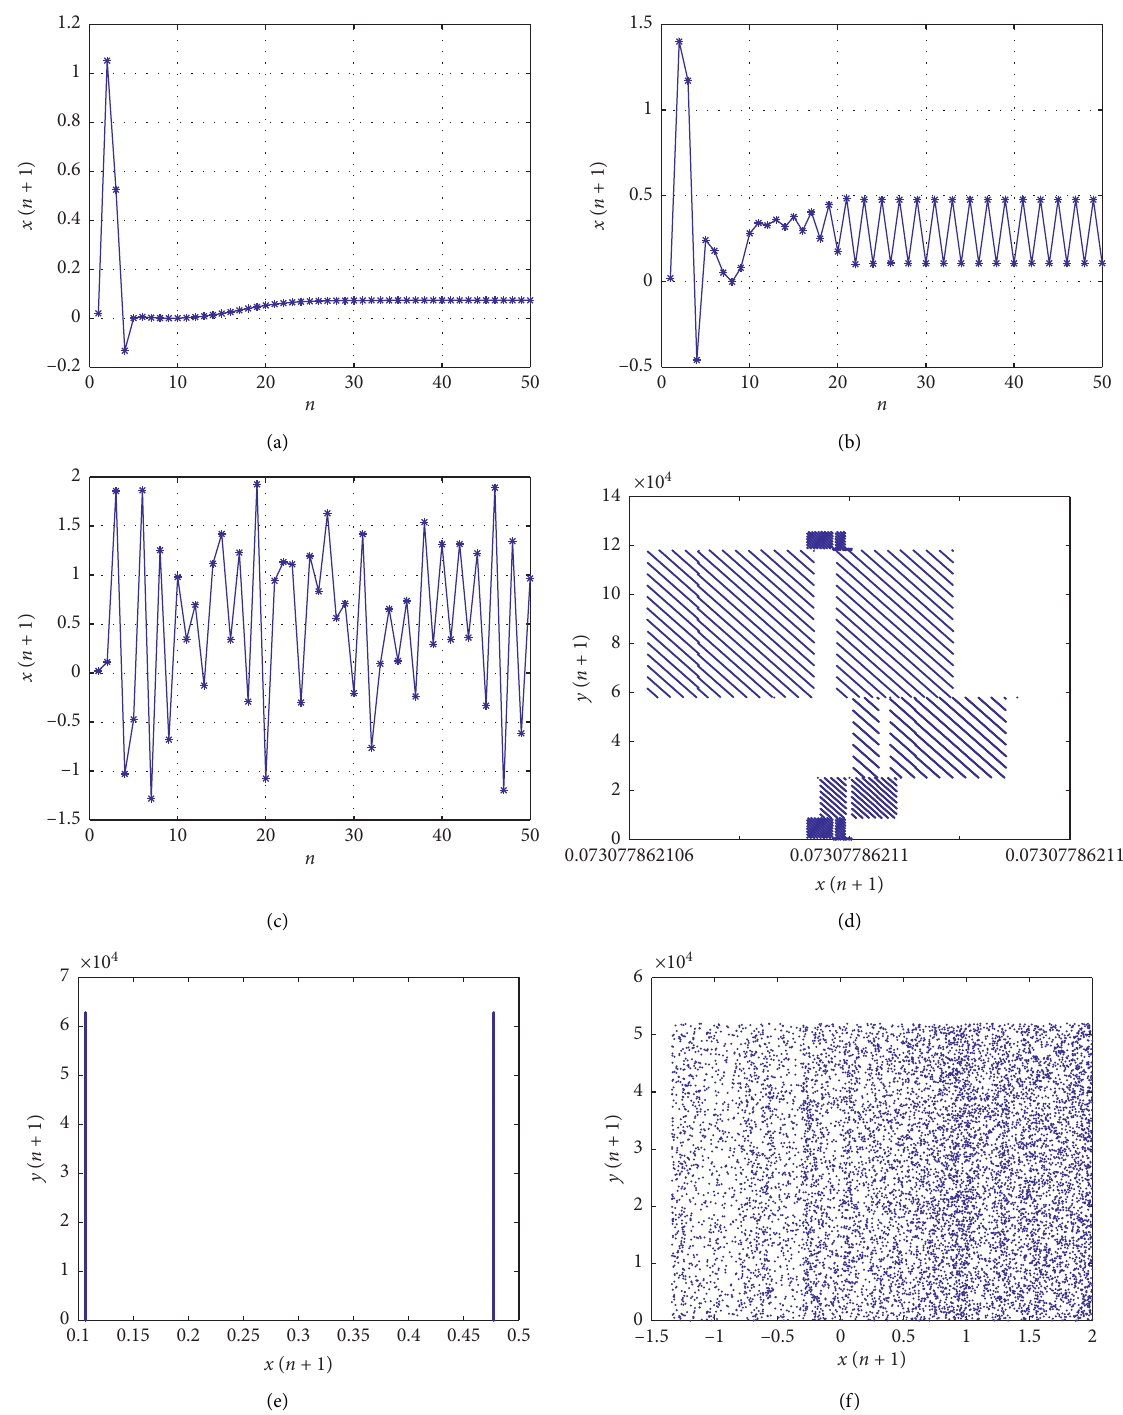
Figure 10: Iteration and trajectory analyses of the fourth proposed chaotic map at x (b) r � 4.45, and (c) r � 7.0. Trajectory property at (d) r � 8.4, (e) r � 4.45, and (f) r �